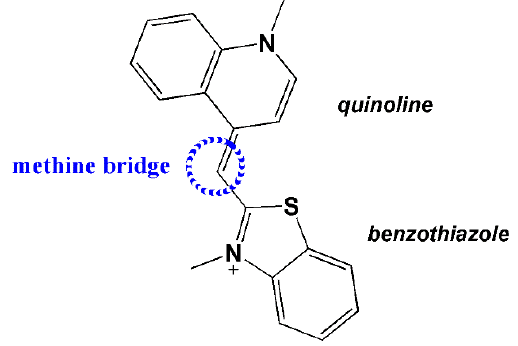
Figure 5. Structure of thiazole orange (TO).